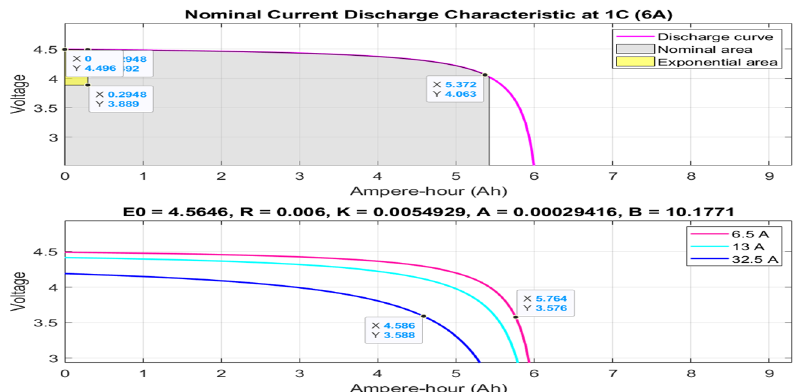
Figure 18. SAFT Li-ion battery nominal current discharge characteristic @1C (6A) (top side view); @6.5A, 13A and 32.5A (bottom view)—Simscape nonlinear model (x-scale is the capacity in Ampere-hour (Ah)).